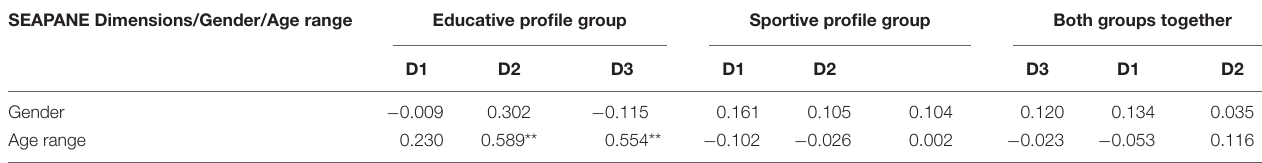
TABLE 3 | Spearman correlation between the dimensions of the Scale for Environmental Attitude in Physical Activities in Natural Environments (SEAPANE), gender and age range of the educative and sportive profile groups, and both groups together (post-test). SEAPANE Dimensions/Gender/Age range Educative profile